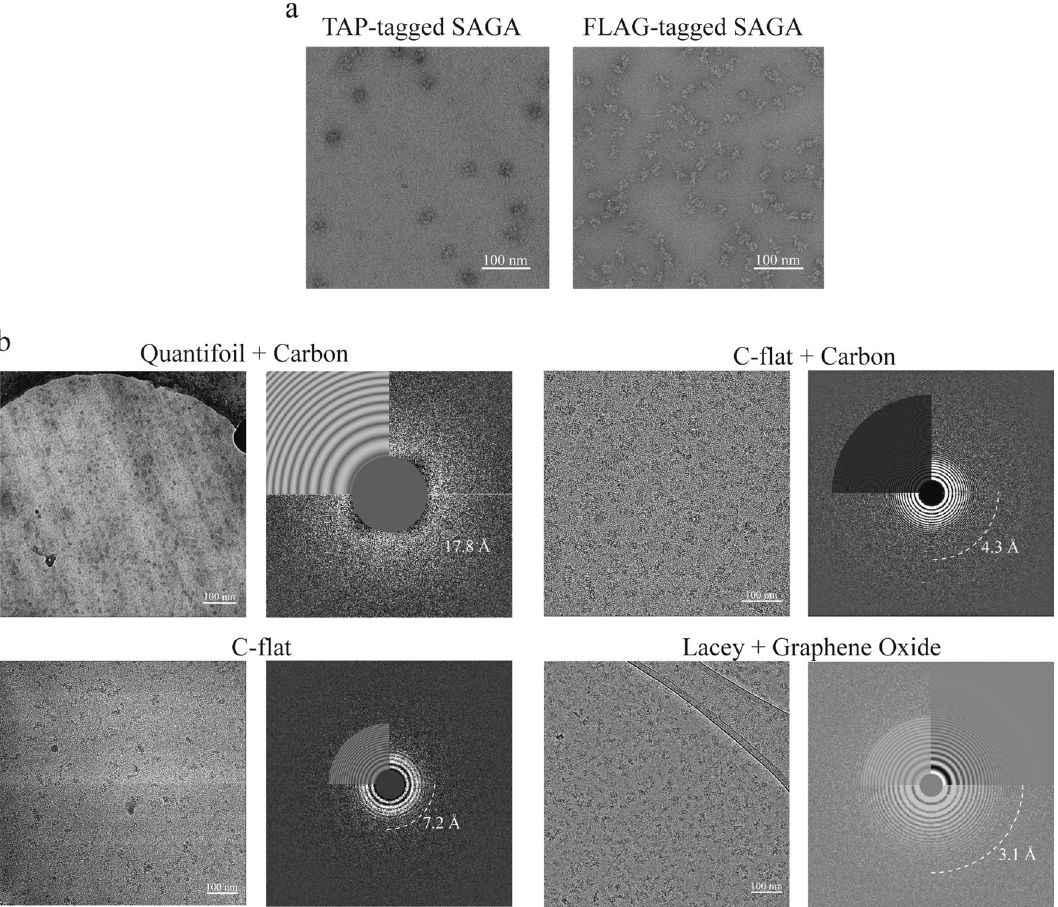
Figure 1. Optimization of S. cerevisiae SAGA cryo-EM specimen preparation. ( a ) Representative raw images of negatively stained TAP-purified and FLAG-purified SAGA. ( b ) Representative cryo-EM micrographs of SAGA vitrified on Quantifoil grids with continuous carbon support taken at a defocus value of 3 μm, C-flat carbon grids without a support layer at a 4.5 μm defocus, C-flat grids with carbon support at a 2.5 μm defocus and Lacey carbon grids with graphene oxide support layer at a defocus value of 2.5